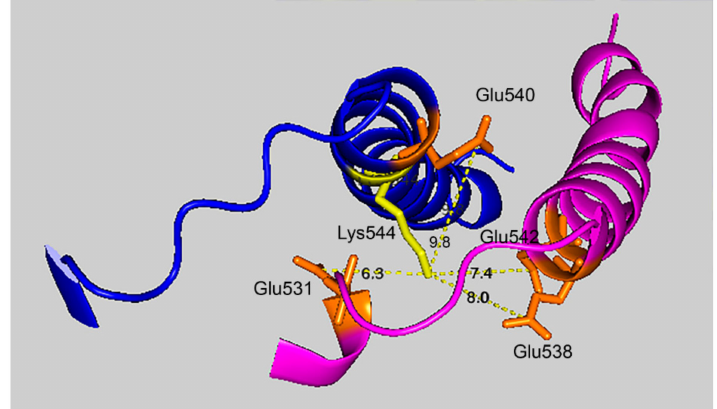
Figure 7. Glutamate promoted formation of the K544–E542 isopeptide bond. C-terminal α -helices from two HuBChE monomers are depicted along with the distances between Lys544 (yellow) and Glu542, Glu540, Glu538, and Glu531 (orange). Deep-blue, purple identify α -helices from di ff erent HuBChE